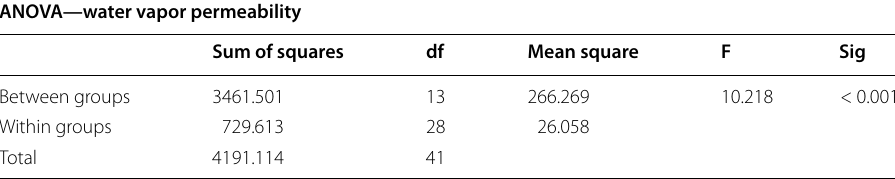
Table 6 The one-way ANOVA test of water vapor permeability ANOVA—water vapor permeability Sum of squares df Mean square F Sig Between groups 3461.501 13 266.269 10.218 < 0.001 Within groups 729.613